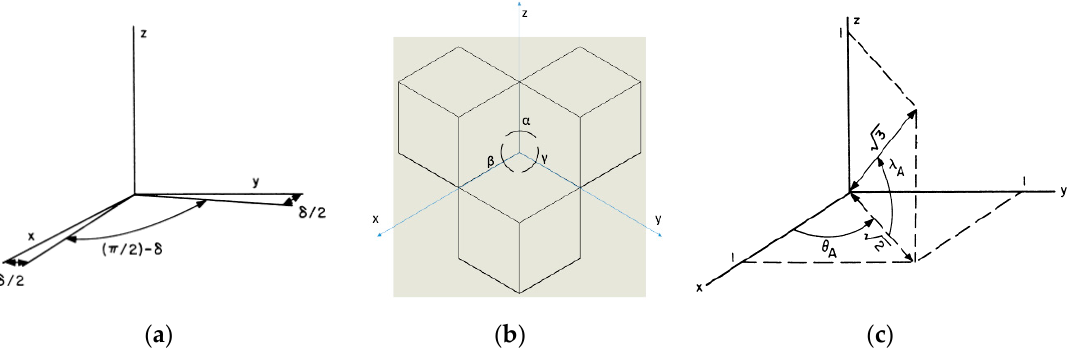
Figure 3. ( a ) Normal to the reflecting faces with dihedral-angle offsets; ( b ) angle between each plane: α = ( π /2)+ δ 1, ; β = ( π /2)+ δ 2 ; γ = ( π /2)+ δ 3 ; and ( c ) direction of symmetry axis.